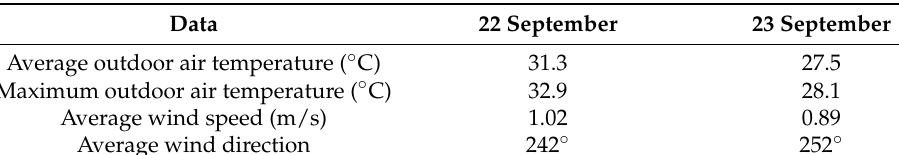
Table 5. Ambient conditions on 22 September and 23 September.